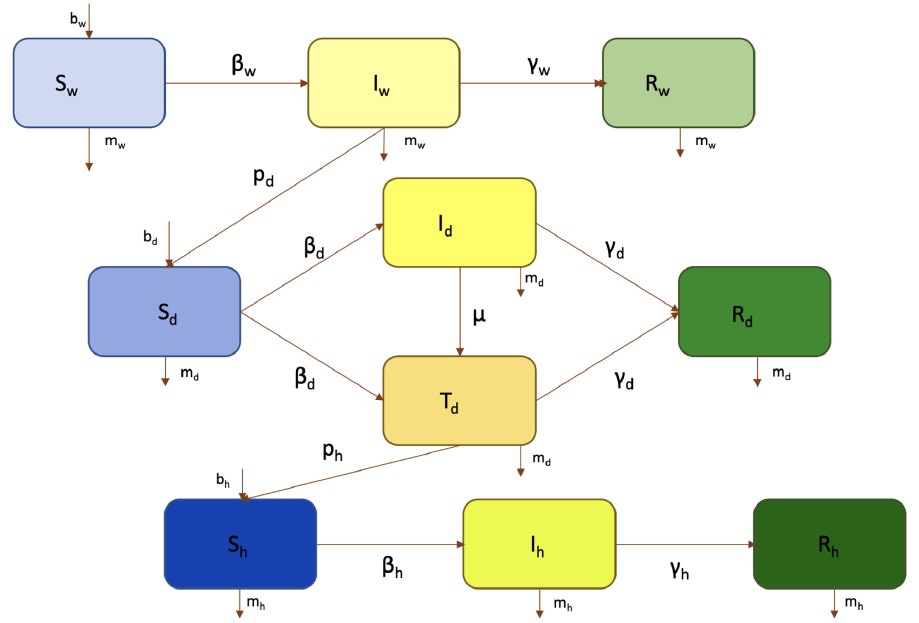
Fig 1. A representation of the model. Model parameters are summarized in Table 3.